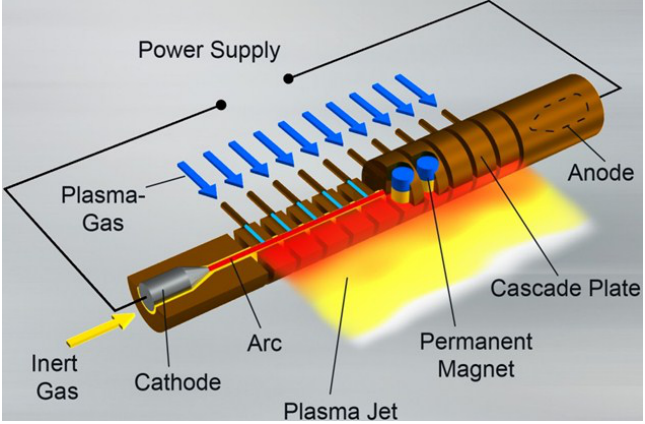
Figure 1. Principle of the long arc generator (LARGE) plasma source (linearly extended DC arc).